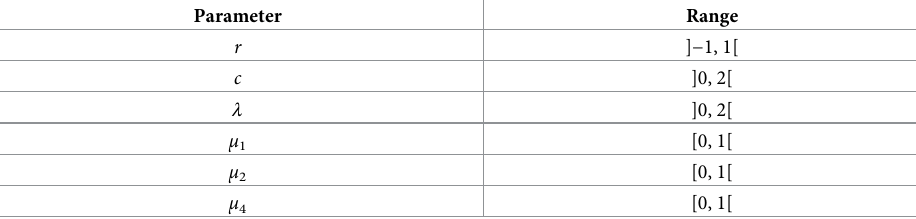
Table 1. Model parameters. The indicated ranges were used as constraints when estimating